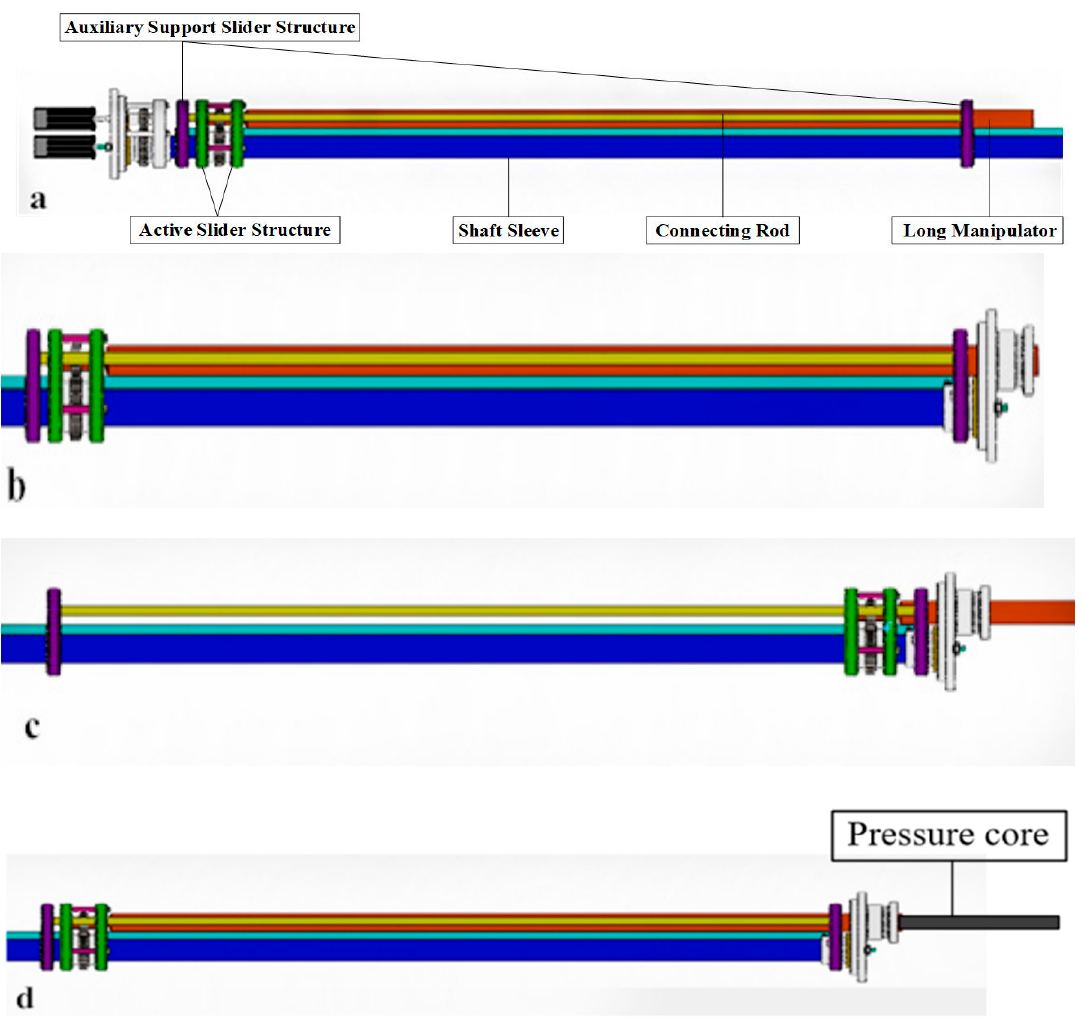
( d ) the pressure core is tested and cut by the testing device and the cutting